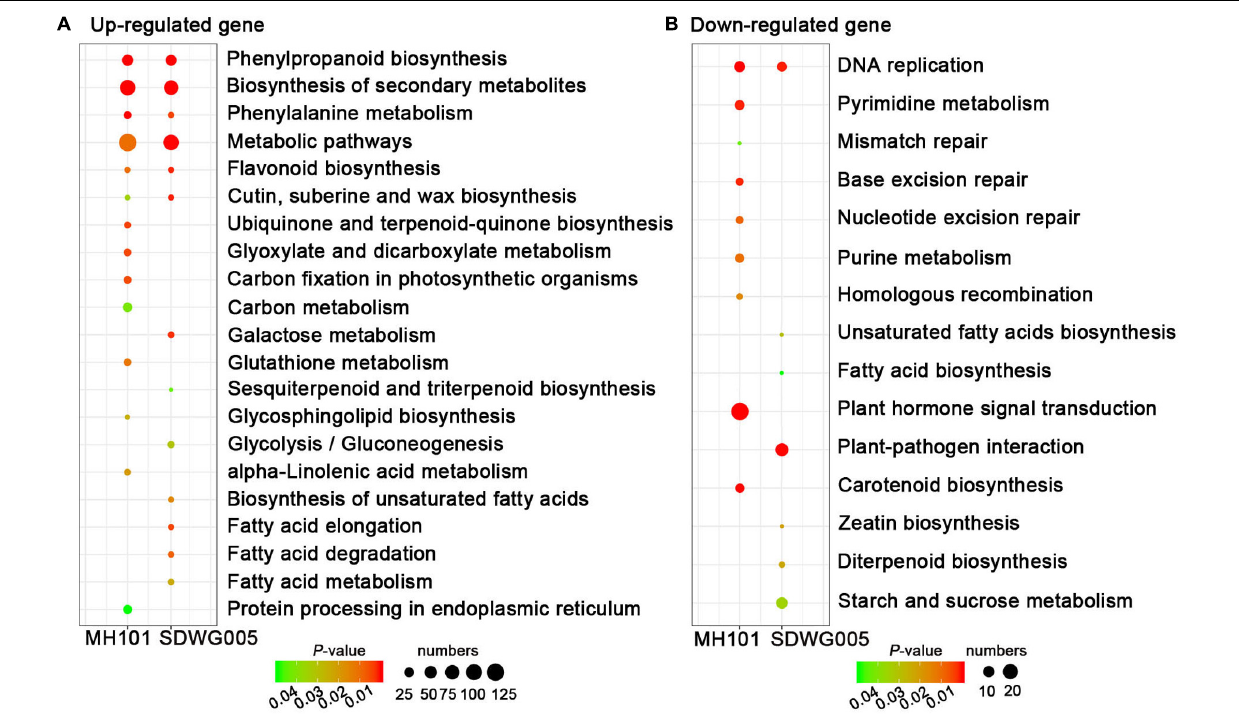
Frontiers in Genetics |